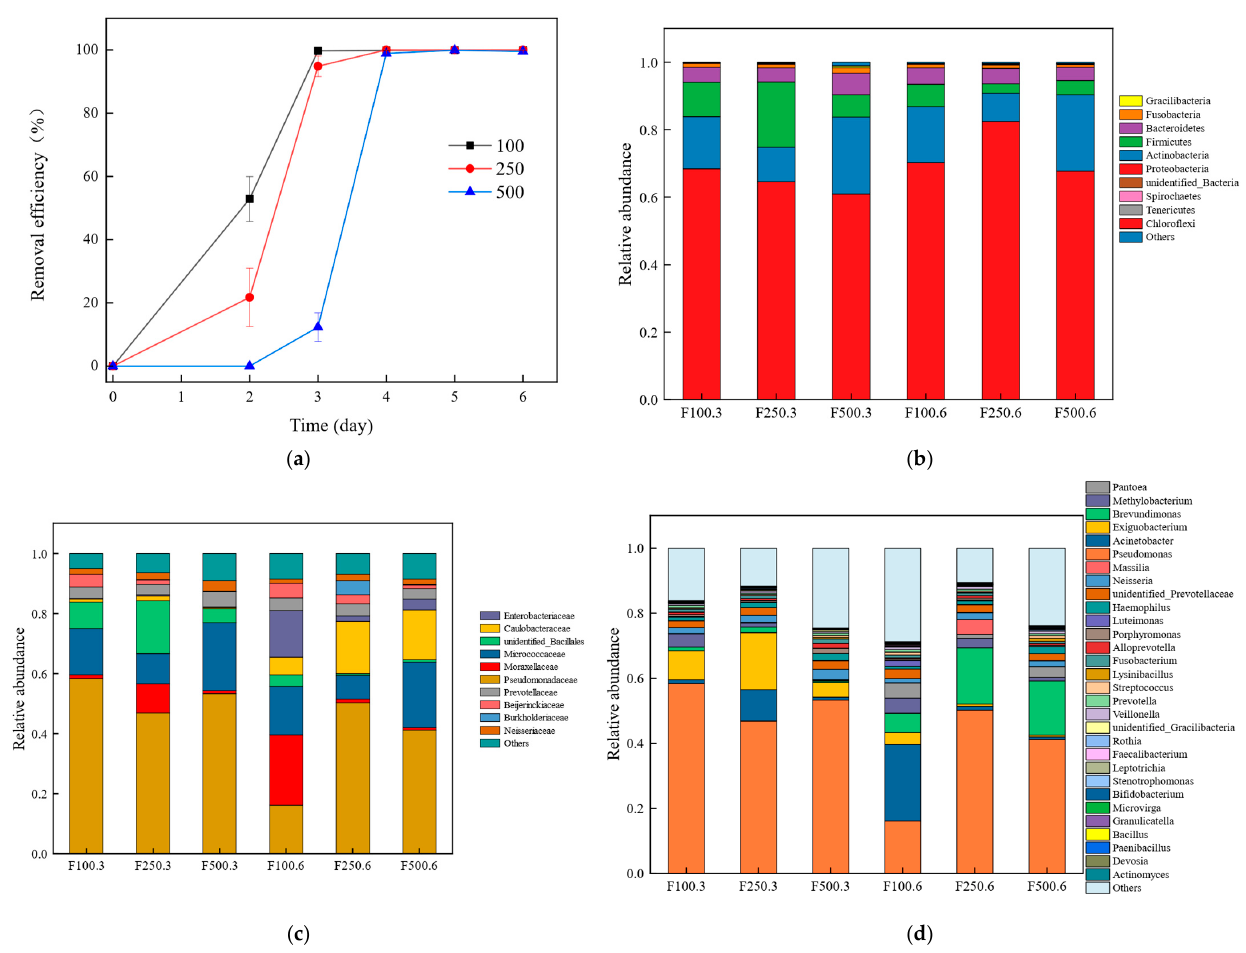
Figure 1. The removal efficiency of PHE ( a ); structural distribution of bacterial community at phylum ( b ), family ( c ), and genus ( d ) levels.